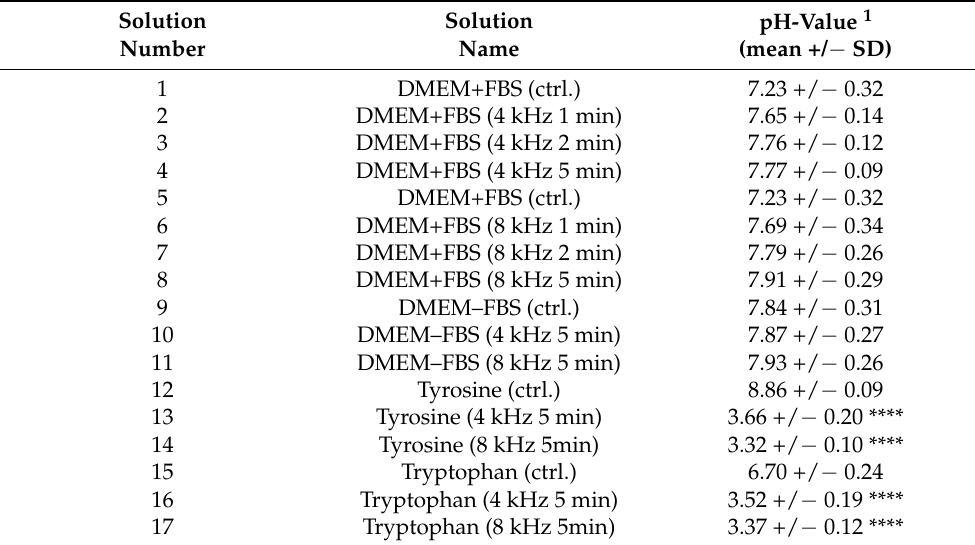
Figure 6. RONS in Tyr and Trp PTS. The RONS in Tyr and Trp PTS were determined after 5 min of 4 kHz and 8 kHz CAP treatment, and were compared to the untreated control (control) (n = 3 in duplicated form). The NO 2 − and NO 3 − concentrations [mM] were measured in Tyr PTS ( A , C ) and in Trp PTS ( B , D ). The median fluorescence intensities (MFI) of the DHR 123 and H 2 O 2 concentrations [ µ M] were determined in Tyr PTS ( E , G ) and Trp PTS ( F , H ), in comparison to the untreated control. Statistical analysis: Bonferroni’s multiple comparisons test. ** p < 0.01, *** p < 0.001, **** p < 0.0001 (4 kHz, 8 kHz versus control), # p < 0.05, ### p < 0.001, #### p < 0.0001 (4 kHz versus 8 kHz). Table 1. pH-value in PTS